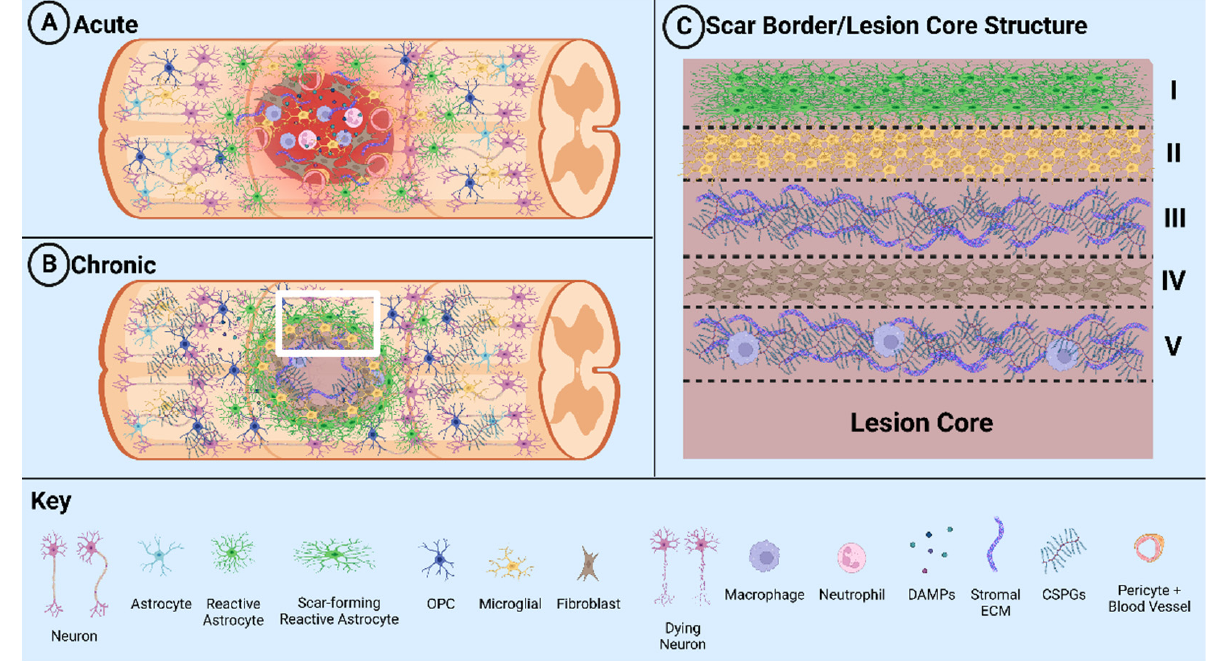
Figure 1. Schematic diagram illustrating glial scar formation. ( A ) Formation of the lesion and scar during the acute phase of SCI. ( B ) Formation of the fibrotic tissue and glial scar during the chronic phase of SCI. ( C ) White box region in B detailing the layers of the glial scar: I. astrocytes, II. microglia, III. secreted stromal ECM/CSPGs, IV. fibroblasts, and V. stromal ECM/CSPGs and penetrating macrophages.